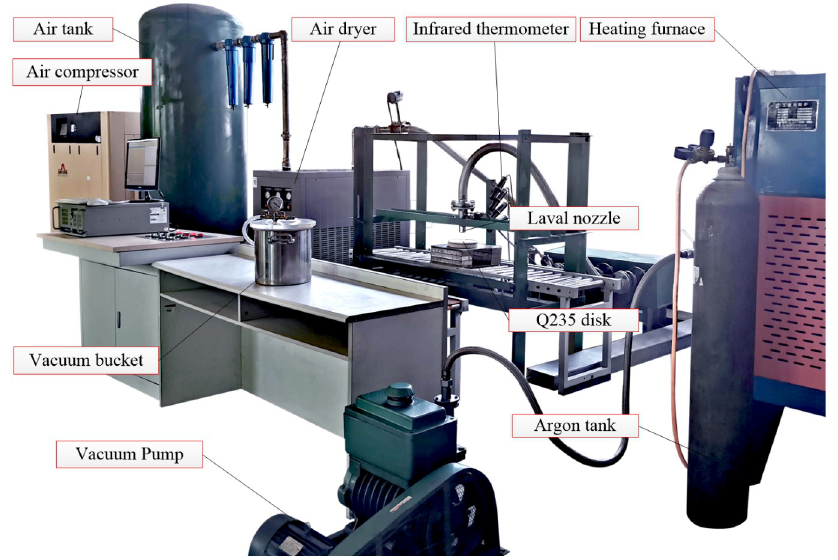
Fig 4. Experimental device of the high-temperature oxidation during the quenching